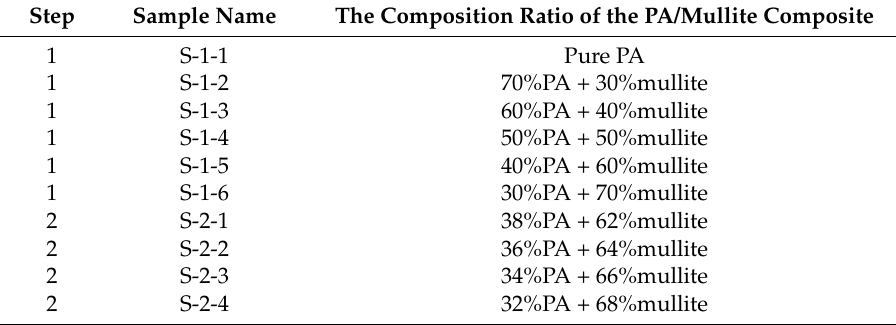
Table 1. The composition ratio of the PA/mullite